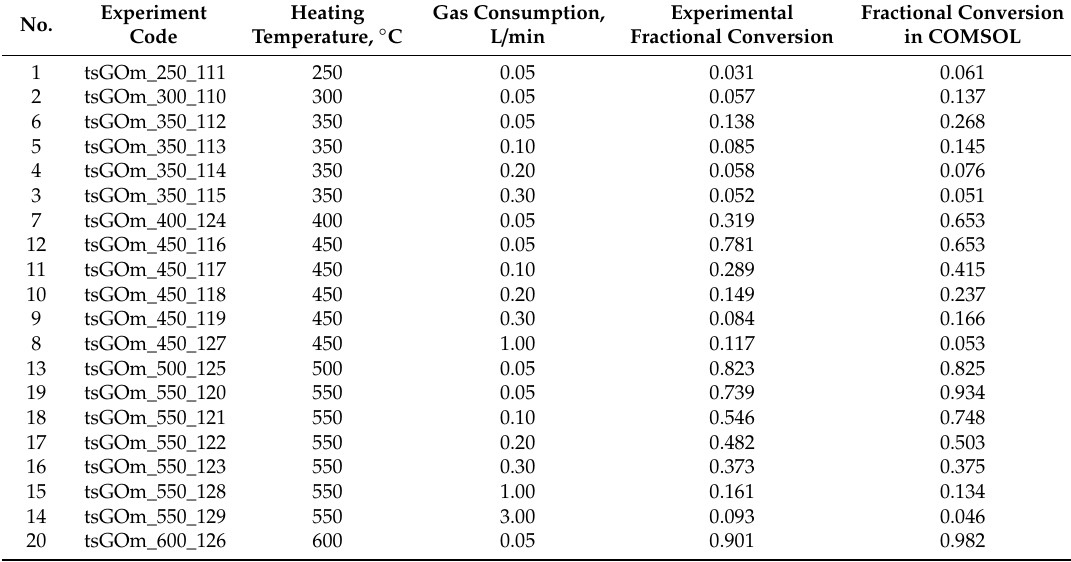
Table 11. Comparison of the experimental fractional conversion of O-methyl-N-cyclohexyl carbamate with the data of the calculation